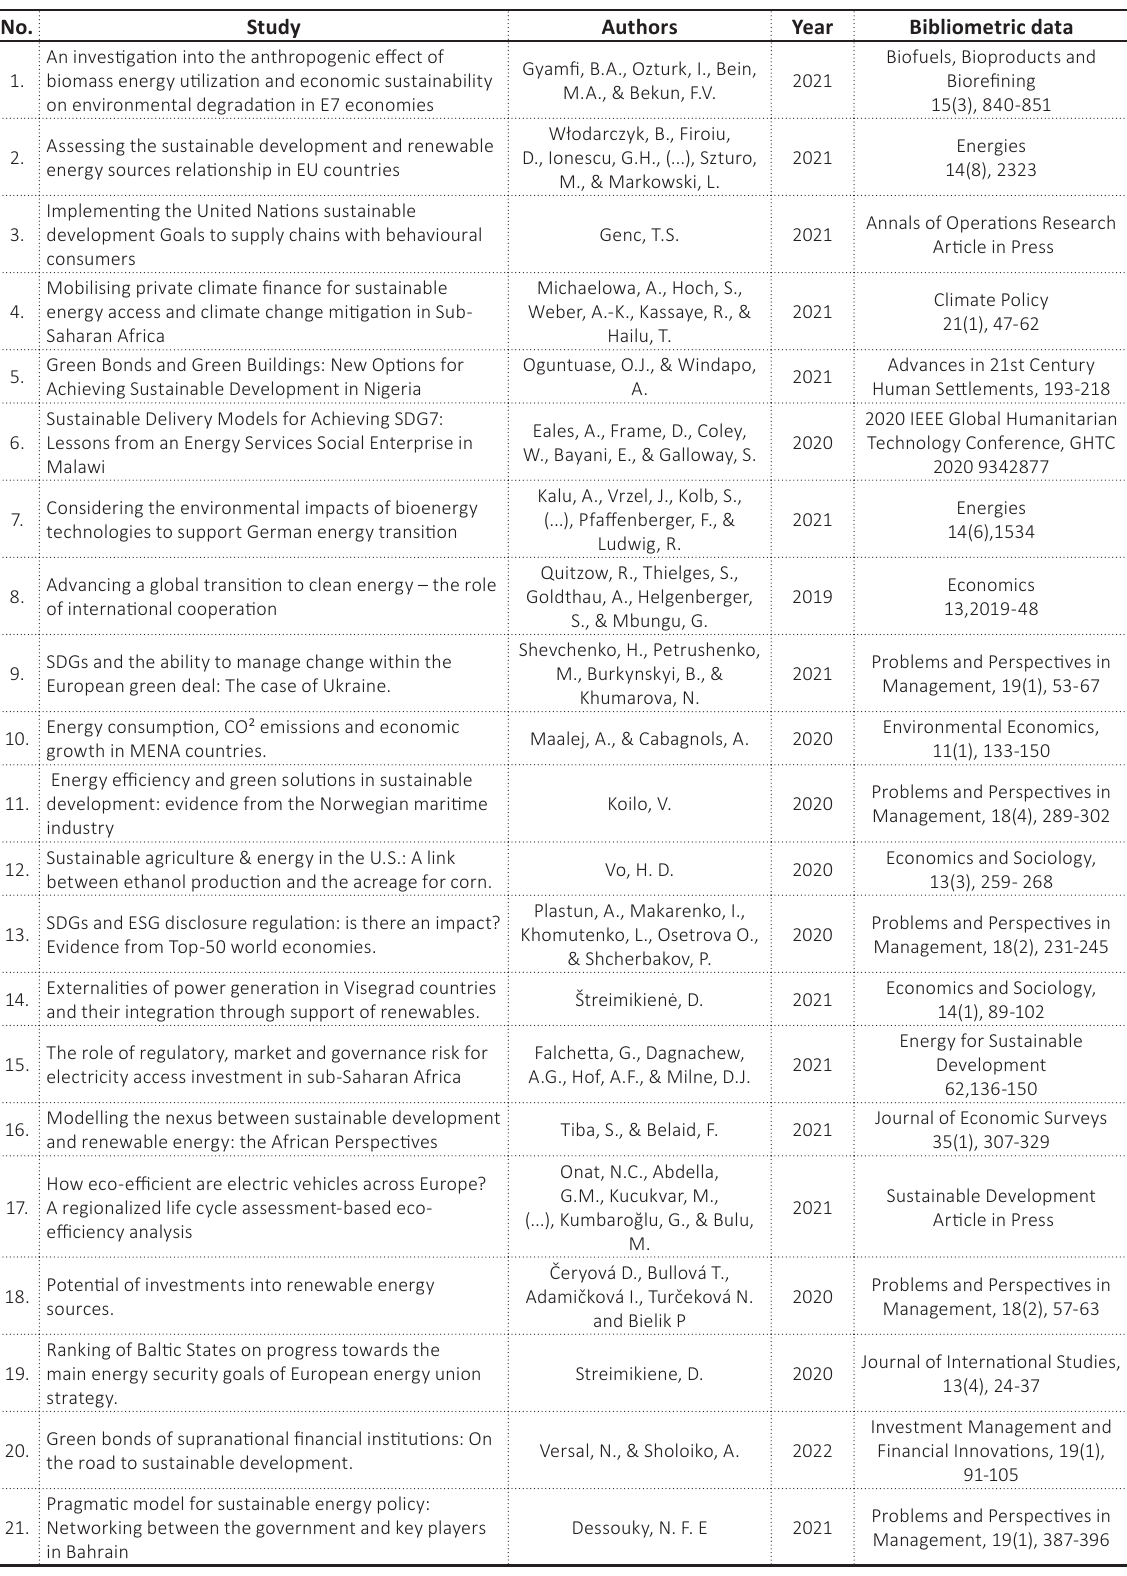
Table E1. List of papers based on a bibliometric map of publications related to SDG 7 and Investment and SDG 7 and Responsible investment, SDG 7 and Investment Gap